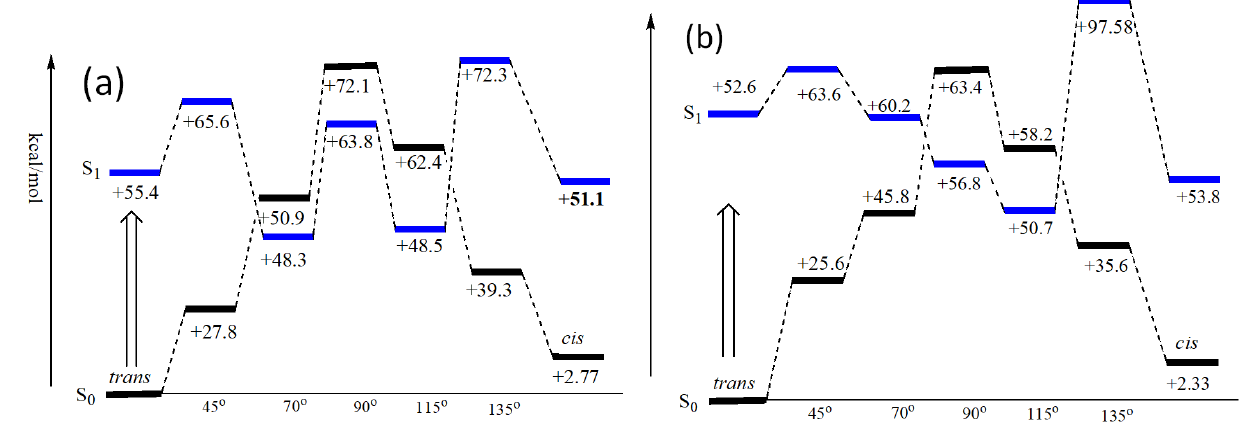
Figure 8. Calculation of S 0 and S 1 energy levels for chalcones of F1 ( a ) and F2 ( b ) at different dihedral angles, showing snapshots of energy surfaces and